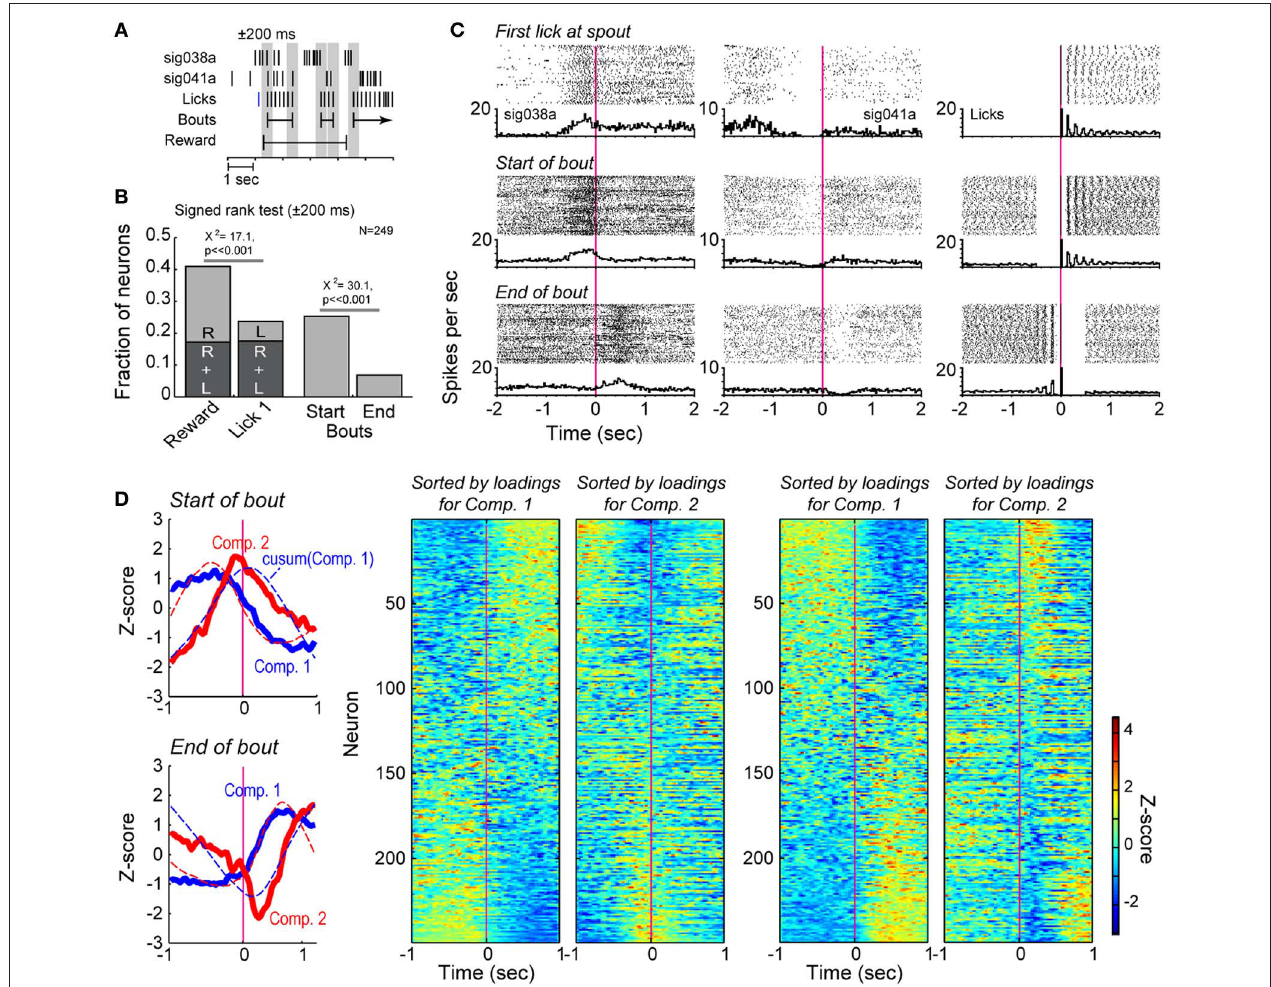
FIGURE 4 | Bout-related modulations of spike activity in the delayed alternation task. (A) Example of the data windows ( ± 200ms) used to assess changes in firing rates around reward delivery and the onset of licking and around bouts of licks. (B) Results from signed rank tests of firing rates around reward delivery (R), onset of licking (L), and the onset and offset of bouts of licking. (C) Two exemplar neurons that showed significant changes in firing rates when rats first licked for reward and emitted bouts of licks. Raster plots and peri-event histograms are shown for the lick events in the right column. (D) Population analysis around the onsets and offsets of the bouts. Two major sources of correlated firing